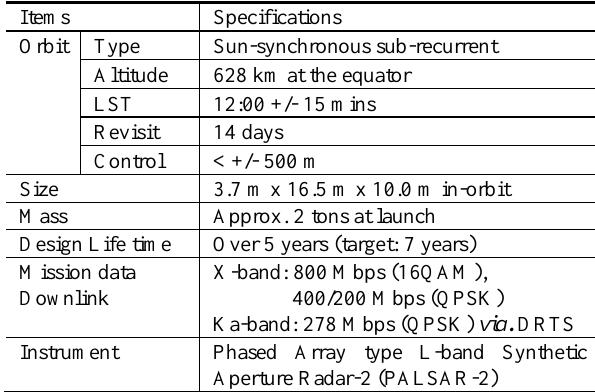
Figure 1. ALOS-2 in-orbit configuration Table 1. ALOS-2